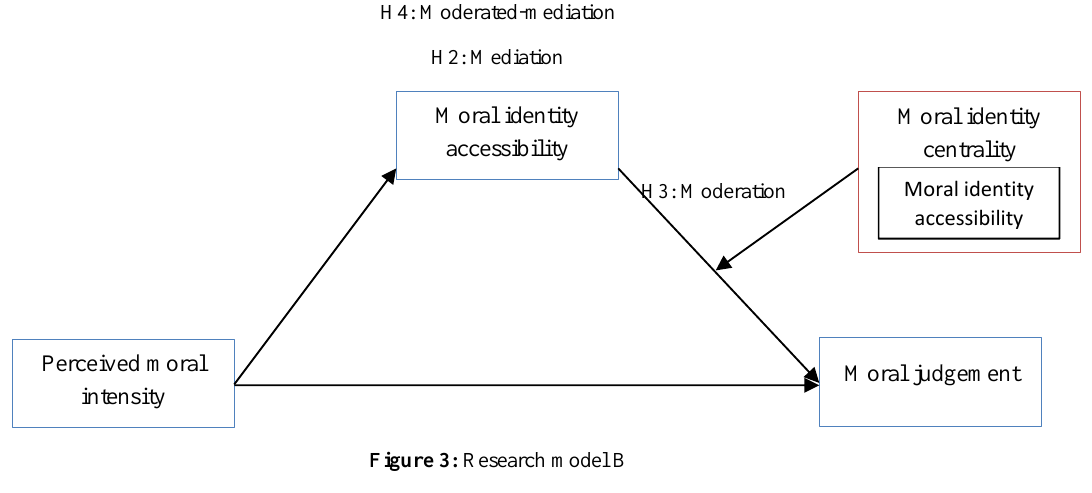
Figure 3: Research model